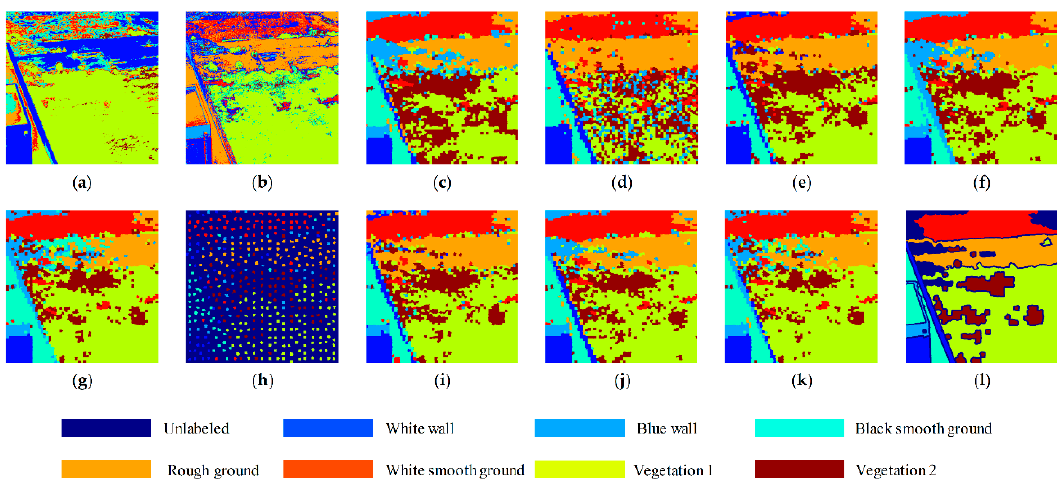
Figure 4. Cluster maps of the different methods of dataset A: ( a ) k-means with S 0 dataset only; ( b ) rank-two nonnegative matrix factorization (R2NMF) with S 0 dataset only; ( c ) sparse subspace clustering (SSC) with S 0 dataset only; ( d ) SSC with DOLP dataset only; ( e ) Polarized Spectral -SSC; ( f ) PS-low-rank representation subspace segmentation (LRR); ( g ) PS-least squares regression subspace segmentation (LSR); ( h ) in-sample clustering result of Fast Polarized Spectral (FPS)-SSC; ( i ) FPS-SSC; ( j ) FPS-LRR; ( k ) FPS-LSR; ( l ) ground truth.